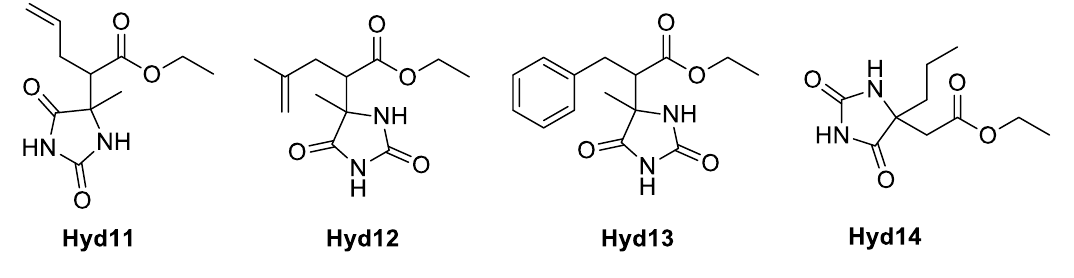
Figure 3. Acetylated hydantoin